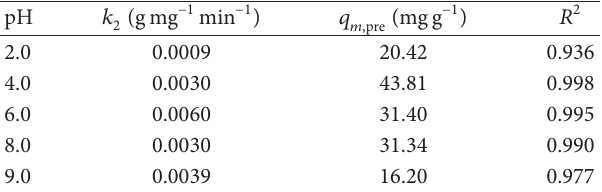
F 4: Effect of temperature (agitation speed =